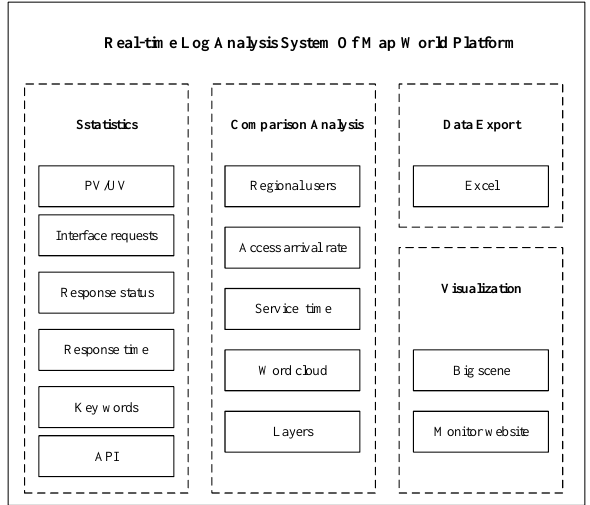
Figure 3. Main functions of the system